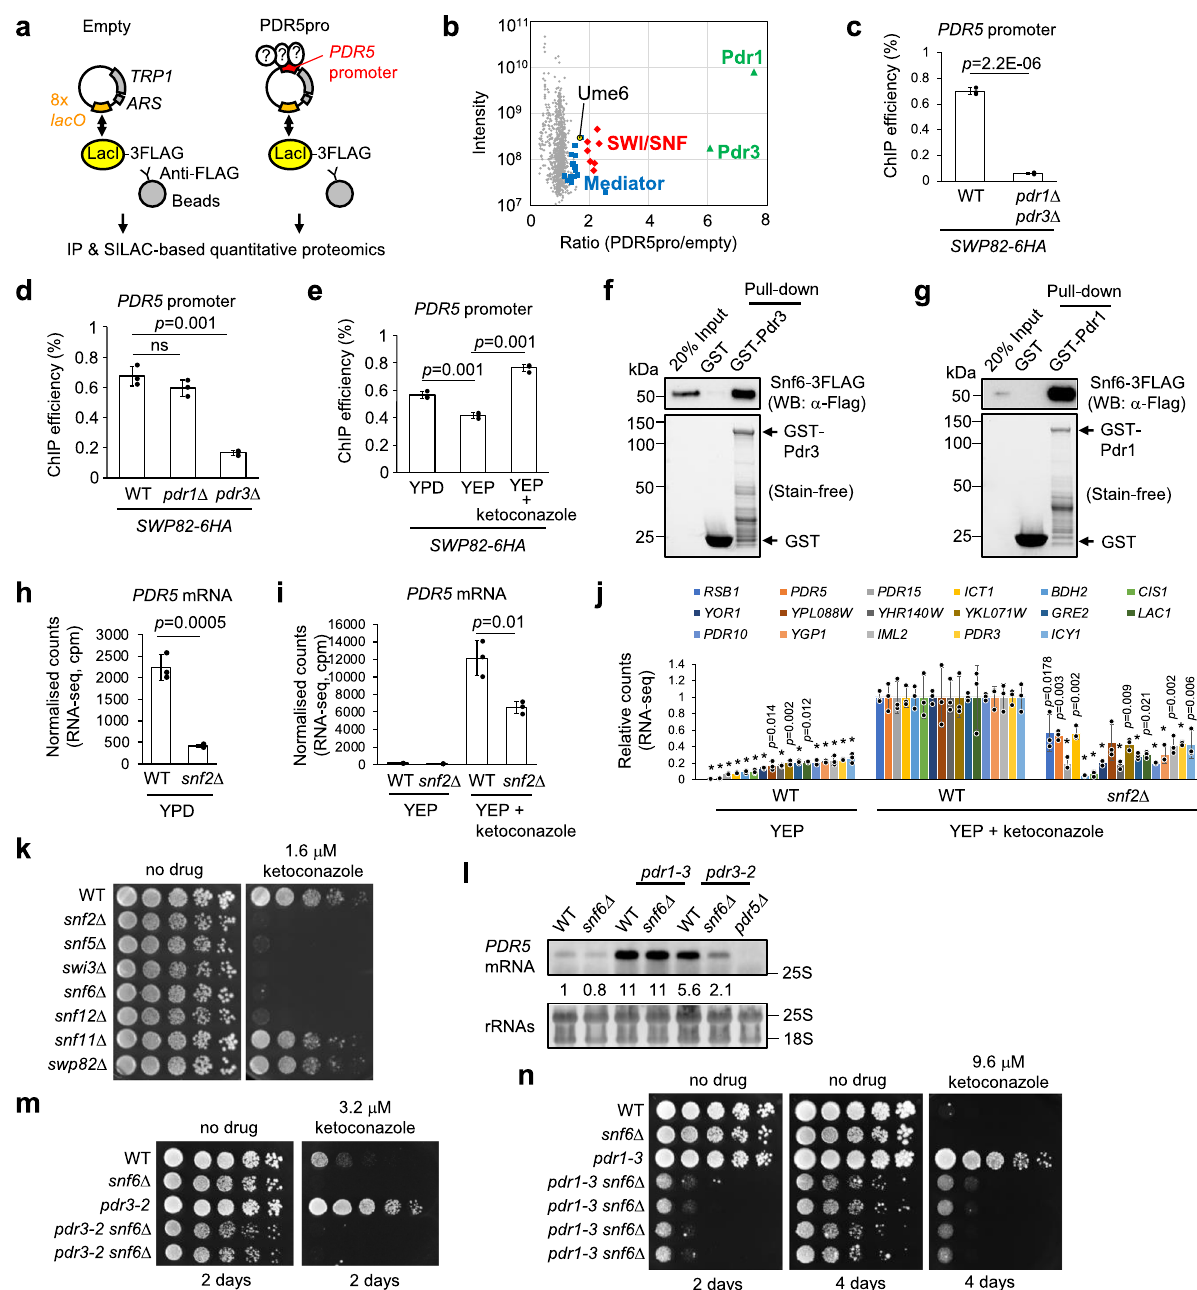
Fig. 5 SWI/SNF is recruited to the PDR5 promoter dependent on Pdr1/3 to upregulate its transcription and confer azole antifungal resistance. a Minichromosome puri fi cation scheme followed by SILAC-based quantitative proteomics. ARS replication origin. TRP1 an auxotrophic selection marker. IP immunoprecipitation. b Ratios of proteins associated with PDR5 promoter minichromosome compared to control minichromosome. Red diamonds, subunits of SWI/SNF; blue squares, subunits of Mediator; green rectangle, Pdr1 or Pdr3; yellow circle, Ume6. Proteins quanti fi ed by at least 5 ratio counts were shown ( n = 1 experiment). c – e ChIP-qPCR analyses of the Swp82 subunit of SWI/SNF at PDR5 promoter, in WT and pdr1 Δ pdr3 Δ ( c ), pdr1 Δ and pdr3 Δ ( d ) in YPD and in response to ketoconazole ( e ). Data are presented as mean values± SD ( n = 3 biological replicates). Unpaired t -test, two-tailed ( c ); one-way ANOVA with post-hoc Tukey HSD tests ( d , e ). ns, P > 0.05. f , g GST pull-down analyses show that the SWI/SNF complex puri fi ed from yeast cells interacts with GST-Pdr3 ( f ) and GST-Pdr1 ( g ). h , i Normalised counts of PDR5 mRNA extracted from RNA-seq data of WT and snf2 Δ grown in YPD ( h ) and treated with ketoconazole ( i ). Data are presented as mean values ± SD ( n = 3 biological replicates). Unpaired t -tests (two-tailed). j Normalised read counts of transcripts of the PDR network genes relative to those in WT treated transiently by ketoconazole in YEP. PDR network genes whose transcripts increased more than four-fold on ketoconazole treatment in WT are shown. Genes whose expression is already higher in snf2 Δ than WT in YEP without ketoconazole are excluded. Data are presented as mean values ± SD ( n = 3 biological replicates). One-way ANOVA with post-hoc Tukey HSD tests, compared to WT treated with ketoconazole. * p = 0.001. k Sensitivity to ketoconazole of deletion mutants of the SWI/SNF subunits. l Northern blot analysis of PDR5 mRNA in indicated mutants in YPD. The intensities relative to PDR5 mRNA prepared from WT are shown below the PDR5 blot. rRNAs, loading control. The positions of 25 S and 18 S rRNAs are shown. m , n Sensitivity to ketoconazole of WT and snf6 Δ in hyperactive pdr3-2 ( m ) and pdr1-3 ( n ) mutant backgrounds. Two and four independent isolates of pdr3-2 snf6 Δ and pdr1-3 snf6 Δ strains used, respectively. NATURE COMMUNICATIONS| (2022) 13:1968 |https://doi.org/10.1038/s41467-022-29591-z|www.nature.com/naturecommunications